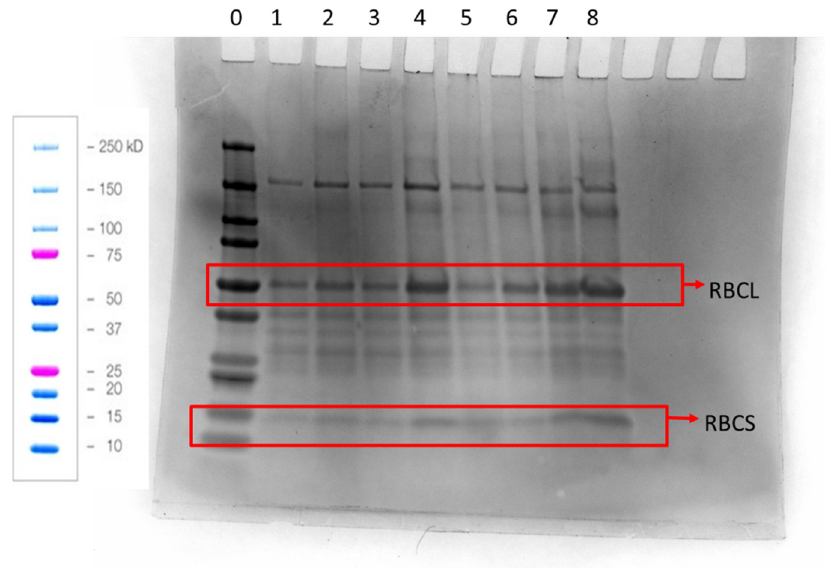
Figure 3. Reduced SDS-PAGE gel of WT, from the twin screw, solubilized in sodium phosphate buffer solution at various pH values (lanes 1–5) or raised to high pH and then lowered to neutral pH (lanes 6–8). Lane 0 = molecular weight standards, lane 1 = pH 7, lane 2 = pH 7.2, lane 3 = pH 7.6, lane 4 = pH 8, lane 5 = pH 8.5, lane 6 = pH 7.6 to 7, lane 7 = pH 8.0 to 7, lane 8 = pH 8.5 to 7. RBCL = large RuBisCO subunit, RBCS = small RuBisCO subunit. The figure on the left with blue and pink coloured bands show Biorad’s instructions of how the standards are expected to run. The same mass of WAPC was used to prepare the sample loaded into each well.